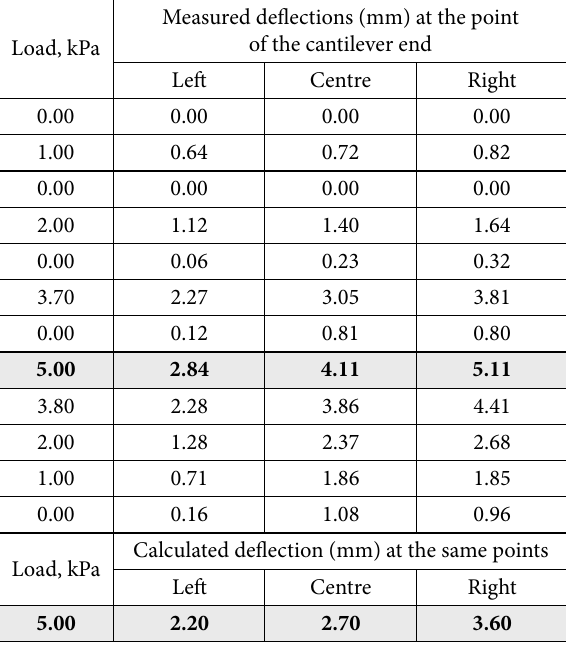
Table 1. Experimentally measured and numerically calculated vertical deflections of cantilevered steel stairs Load,